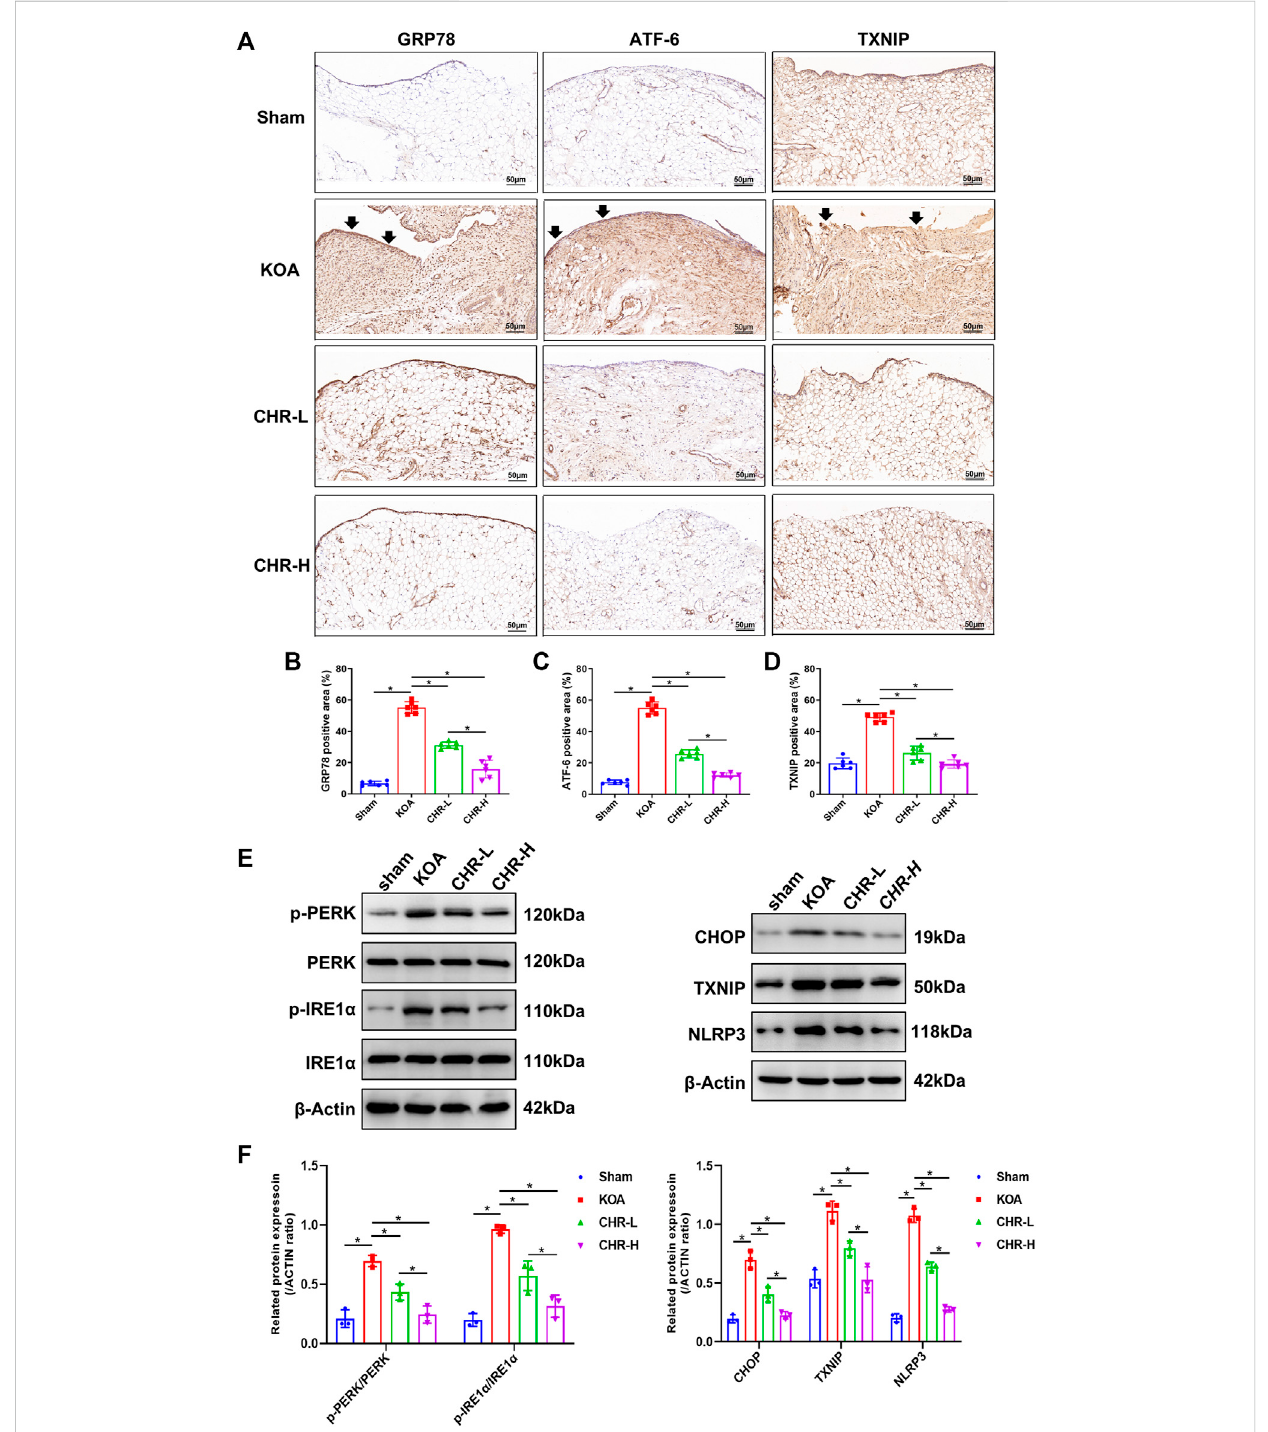
CHR downregulates the expression of proteins related to the PERK/TXNIP/NLRP3 signaling axis in KOA rats. (A) Immunohistochemical analysis of synovium slices from sham, KOA or CHR rats using anti-GRP78, anti-ATF-6, and anti-TXNIP antibodies at ×200 magni fi cation. n = 6. Scale bars: 50 μ m. The positive areas were mainly around the synovial membrane and vessels (black arrow). (B – D) The percentage of GRP78-, ATF-6- and TXNIP-positive areas in each group. (E) The protein levels of p-PERK/PERK, p-IRE1 α /IRE1 α , CHOP, TXNIP and NLRP3 were determined. (F) The levels of these proteins in the sham, KOA, CHR-L and CHR-H groups. n = 3 per group. The data in this fi gure are presented as the mean ± standard deviation, and statistical signi fi cance was determined with one-way ANOVA followed by Tukey ’ s post hoc analysis. p p <